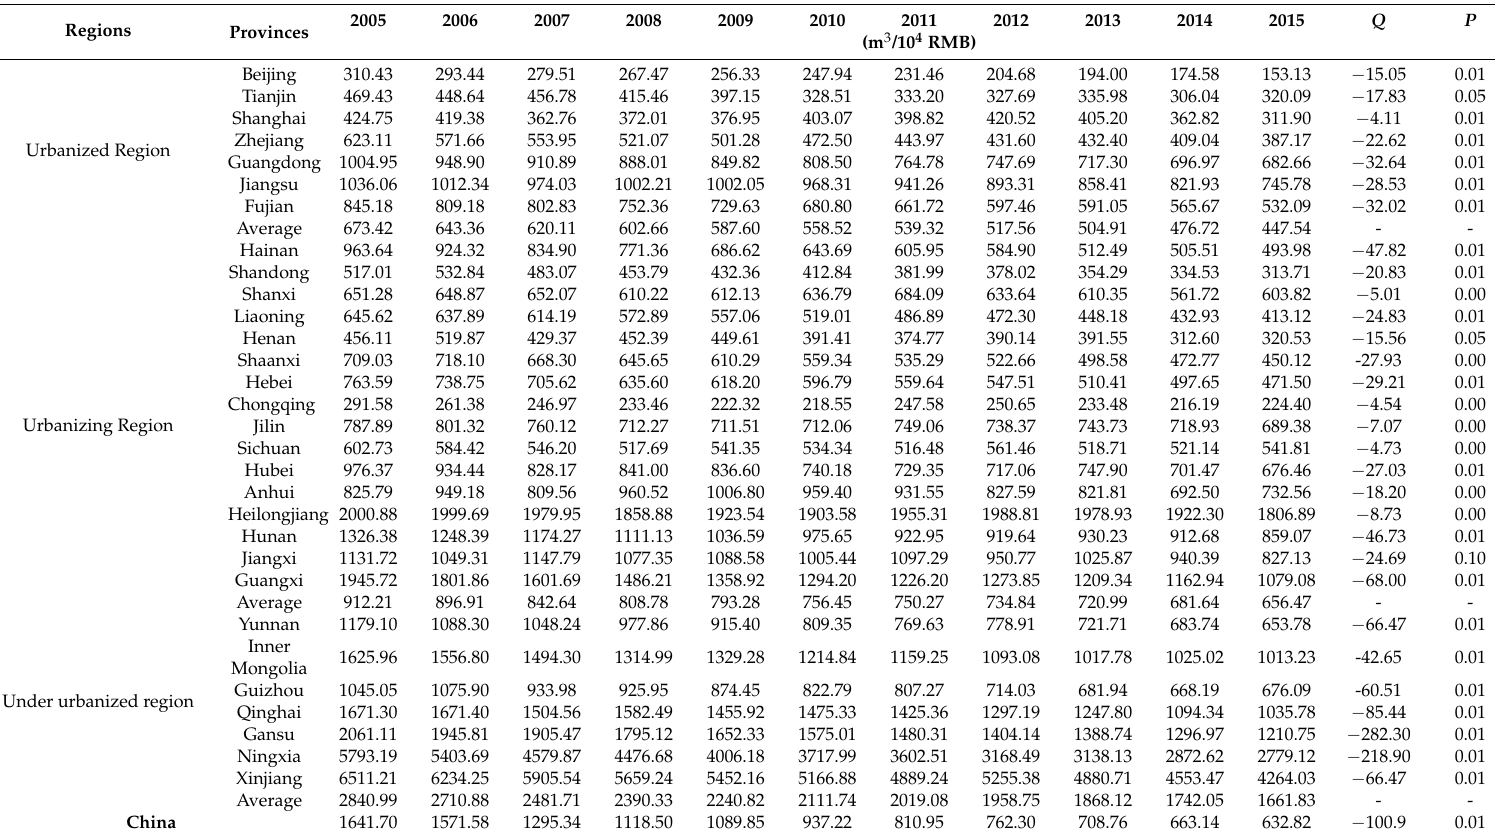
Table A2. China’s water use intensity (WUI), Sen’s slope (Q), and significance level (P) of primary industry (PI) at provincial and national levels between 2005 and